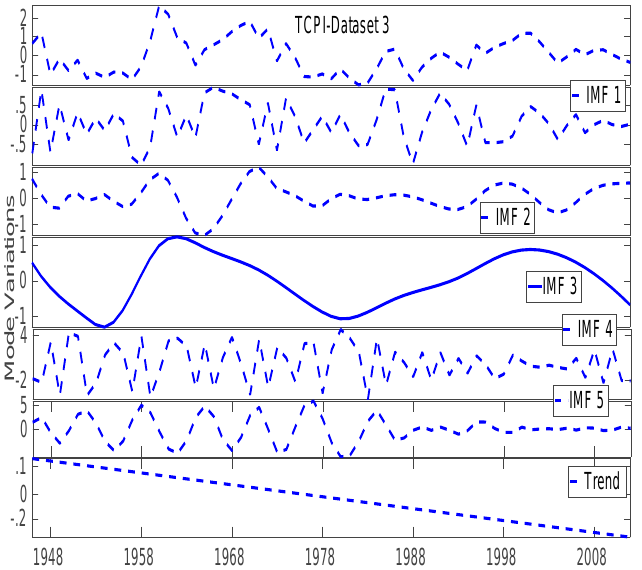
Figure 4. The EMD analysis of the TCPI signal in the North Indian Ocean. TCPI used here is derived using Dataset-3. The derived signal is shown in the first panel and its trend in the seventh panel. The third mode (IMF 3) retained for further analysis is shown in bold.